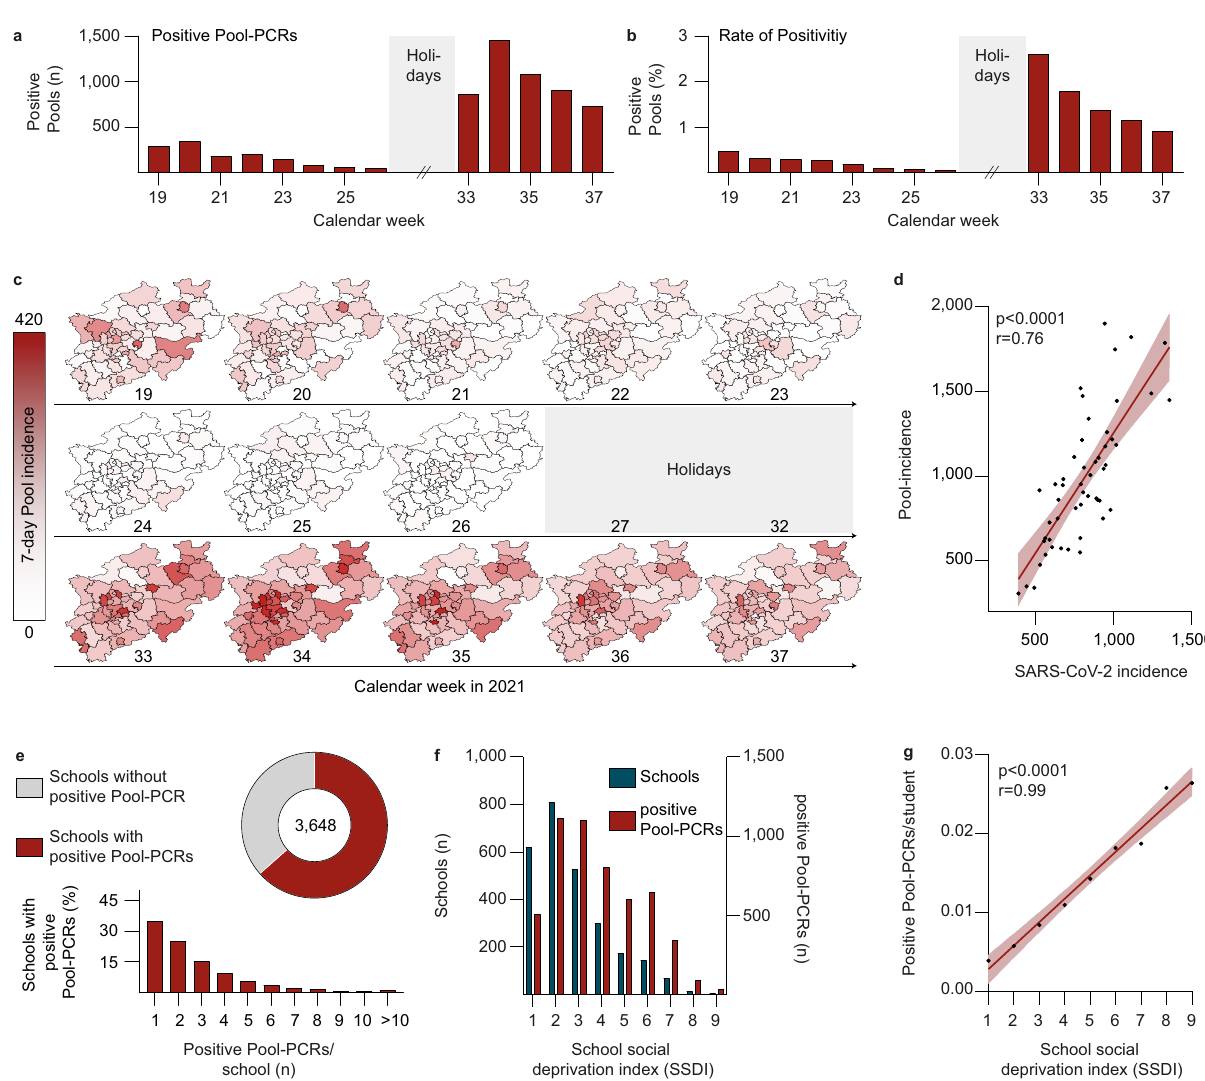
Fig. 3 Monitoring SARS-CoV-2 infections in schools. a The number of positive pool-RT-qPCRs is strati fi ed by calendar week. b The rate of positivity of pool-RT-qPCRs is strati fi ed by calendar week. c Maps of North Rhine-Westphalia depicting the 7-day pool-incidence per week and district. d Spearman correlation (two-tailed) between pool-incidence and SARS-CoV-2 incidence ( p < 0.0001, r = 0.76). Each black dot represents one district of North Rhine- Westphalia. 95% CI is indicated by the bright red area. e Fraction of schools with at least one positive pool-RT-qPCR (pie-chart) and fraction of schools strati fi ed by corresponding number of positive Pool-RT-qPCRs per school (bar chart). f Number of schools and positive pool-RT-qPCR strati fi ed by school social deprivation index level. g Spearman correlation (two-tailed) between number of positive pool-RT-qPCRs/student and school social deprivation index level ( p < 0.0001, r = 0.99). 95% CI is indicated by the bright red